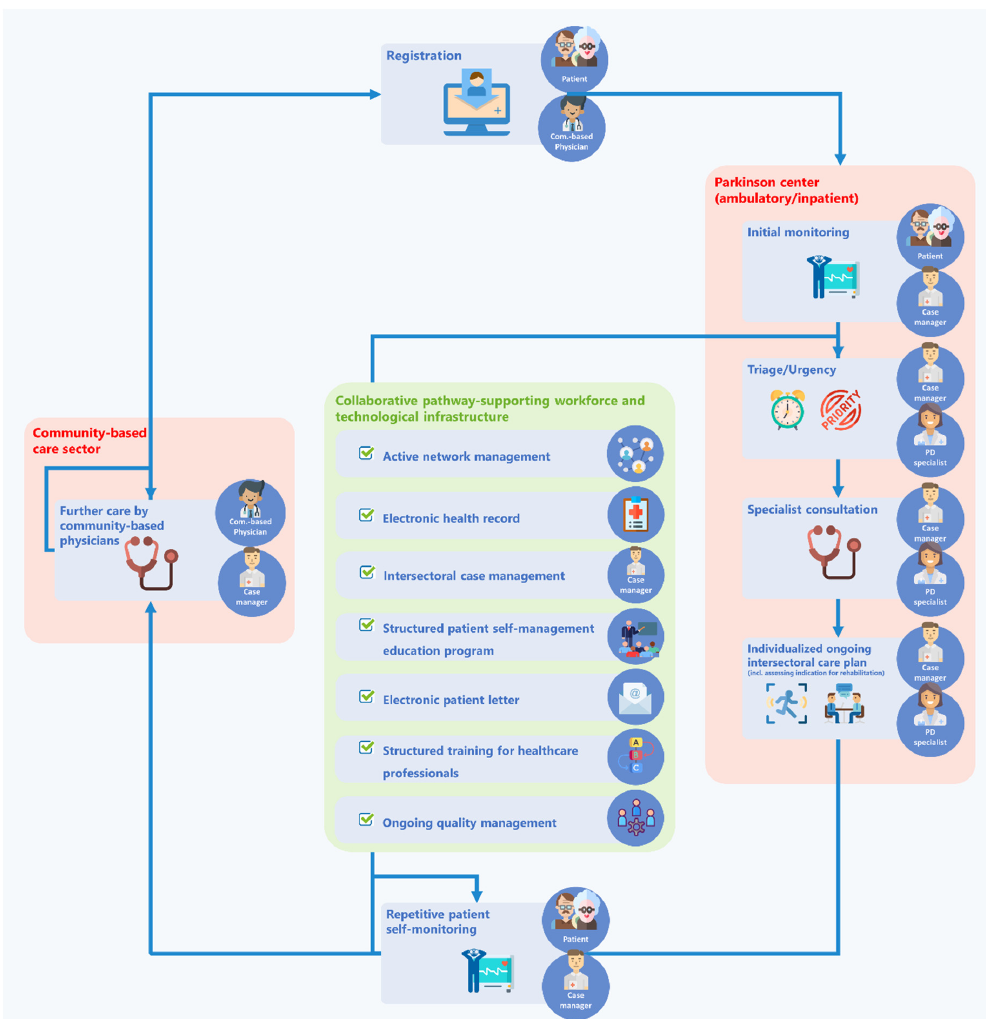
Figure 2. The PANOS care pathway with its supporting workforce and technological infrastructure.